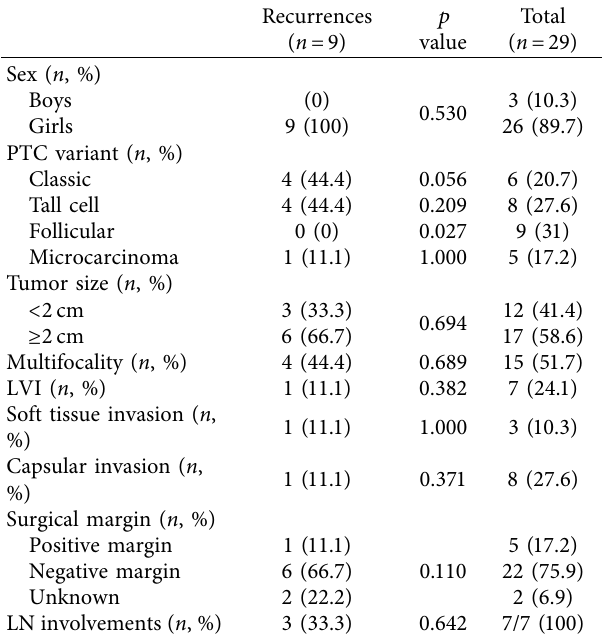
Table 6: The correlation between pathological characteristics with